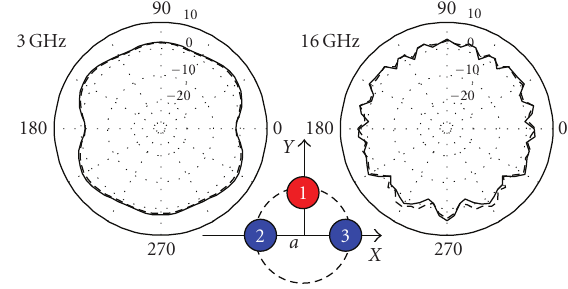
Figure 12: Three-bicone circular array with feeding on antenna 1 and open-circuit on antennas 2 and 3. Expected azimuth (X-Y plane) radiation pattern (solid line) and SC approximation (dot line).